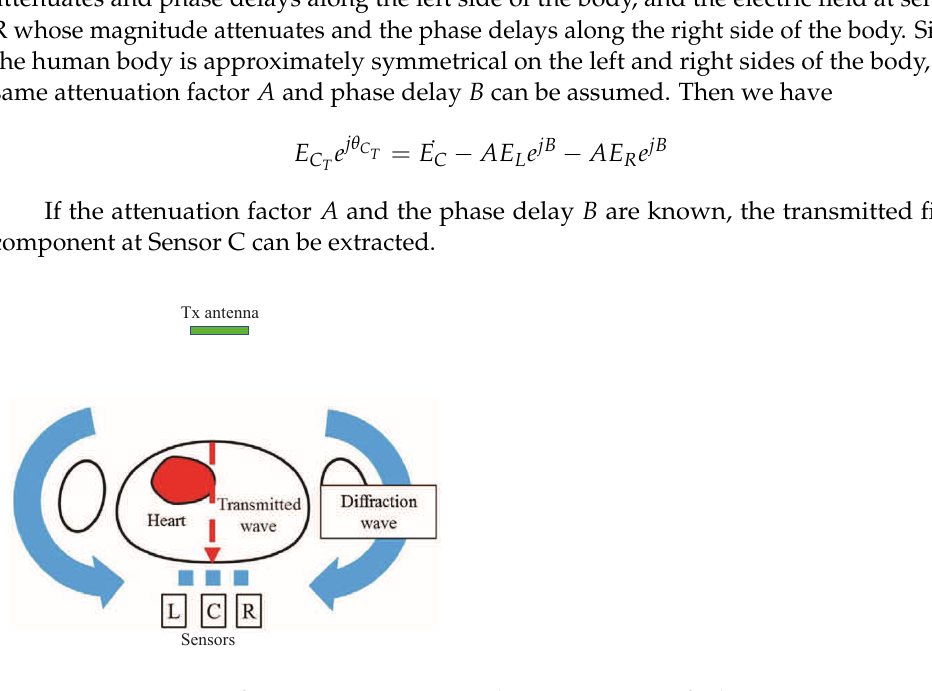
Figure 5. Arrangement of transmitting antenna and receiving sensors for heart-rate